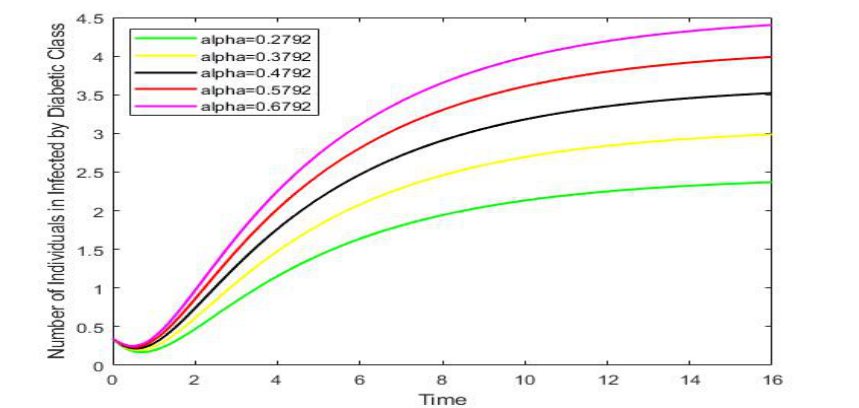
Figure 7: Infected by Diabetic class for different values of α with control param-